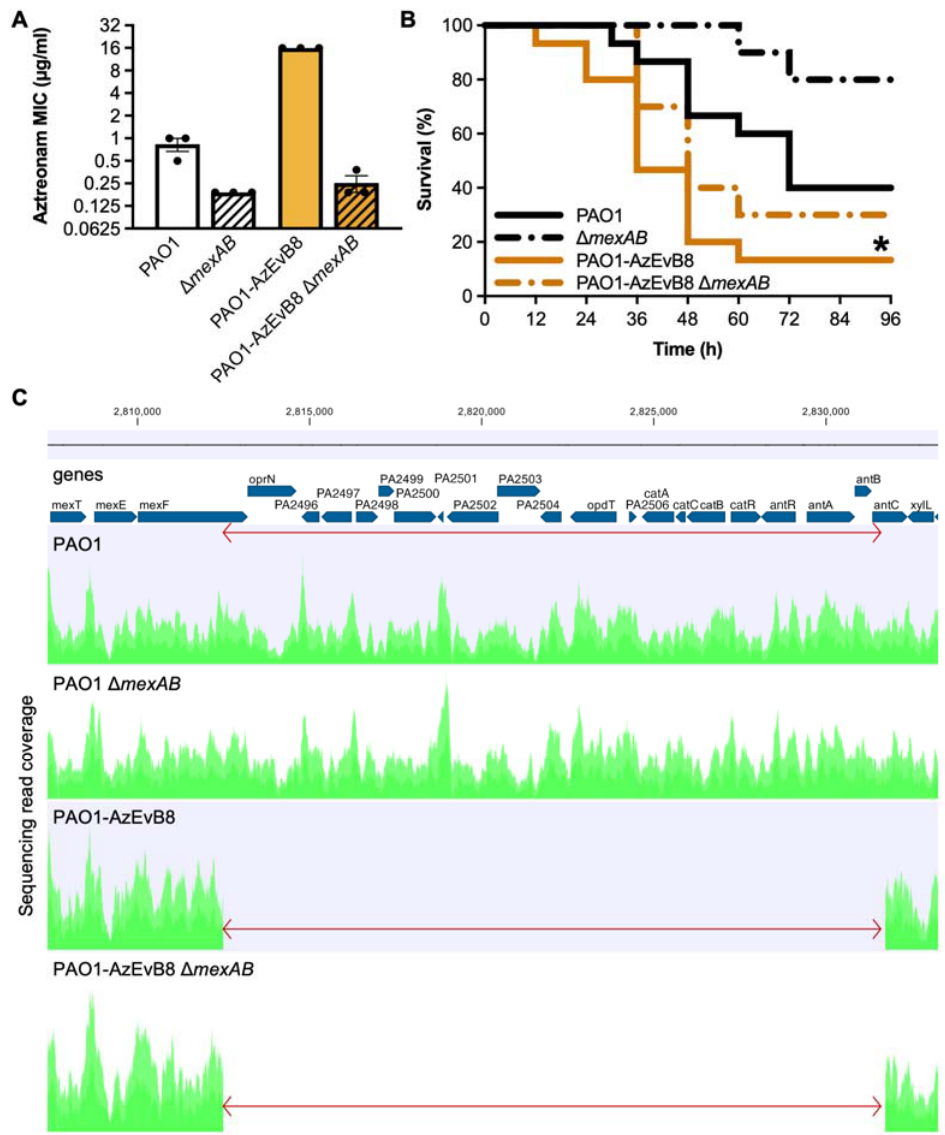
Figure 1. MexAB-OprM is not involved in the PAO1-AzEvB8 mutant in vivo virulence. ( A ) Deletion of the mexAB genes abrogates aztreonam resistance in strain PAO1-AzEvB8. Aztreonam MICs were determined by gradient diffusion assays (n = 3 replicates/group; MIC: minimum inhibitory concentration). ( B ) mexAB deletion in PAO1-AzEvB8 mutant does not significantly improve mouse survival following acute lung infection. Log-rank test was used to compare survival curves. * p < 0.05 compared to WT PAO1; n = 10–15 mice/group. ( C ) Genome diagram showing coverage of sequencing reads aligning to the region spanning mexEF through xylZ . The 19,233 bp deleted region (indicated by the red arrow) in strains PAO1-AzEvB8 and PAO1-AzEvB8 ∆ mexAB begins at the 3 (cid:48) end of mexF and continues through the 5 (cid:48) region of antC . Genome coverage plots generated from sequencing read alignments to the PAO1 reference genome are indicated in